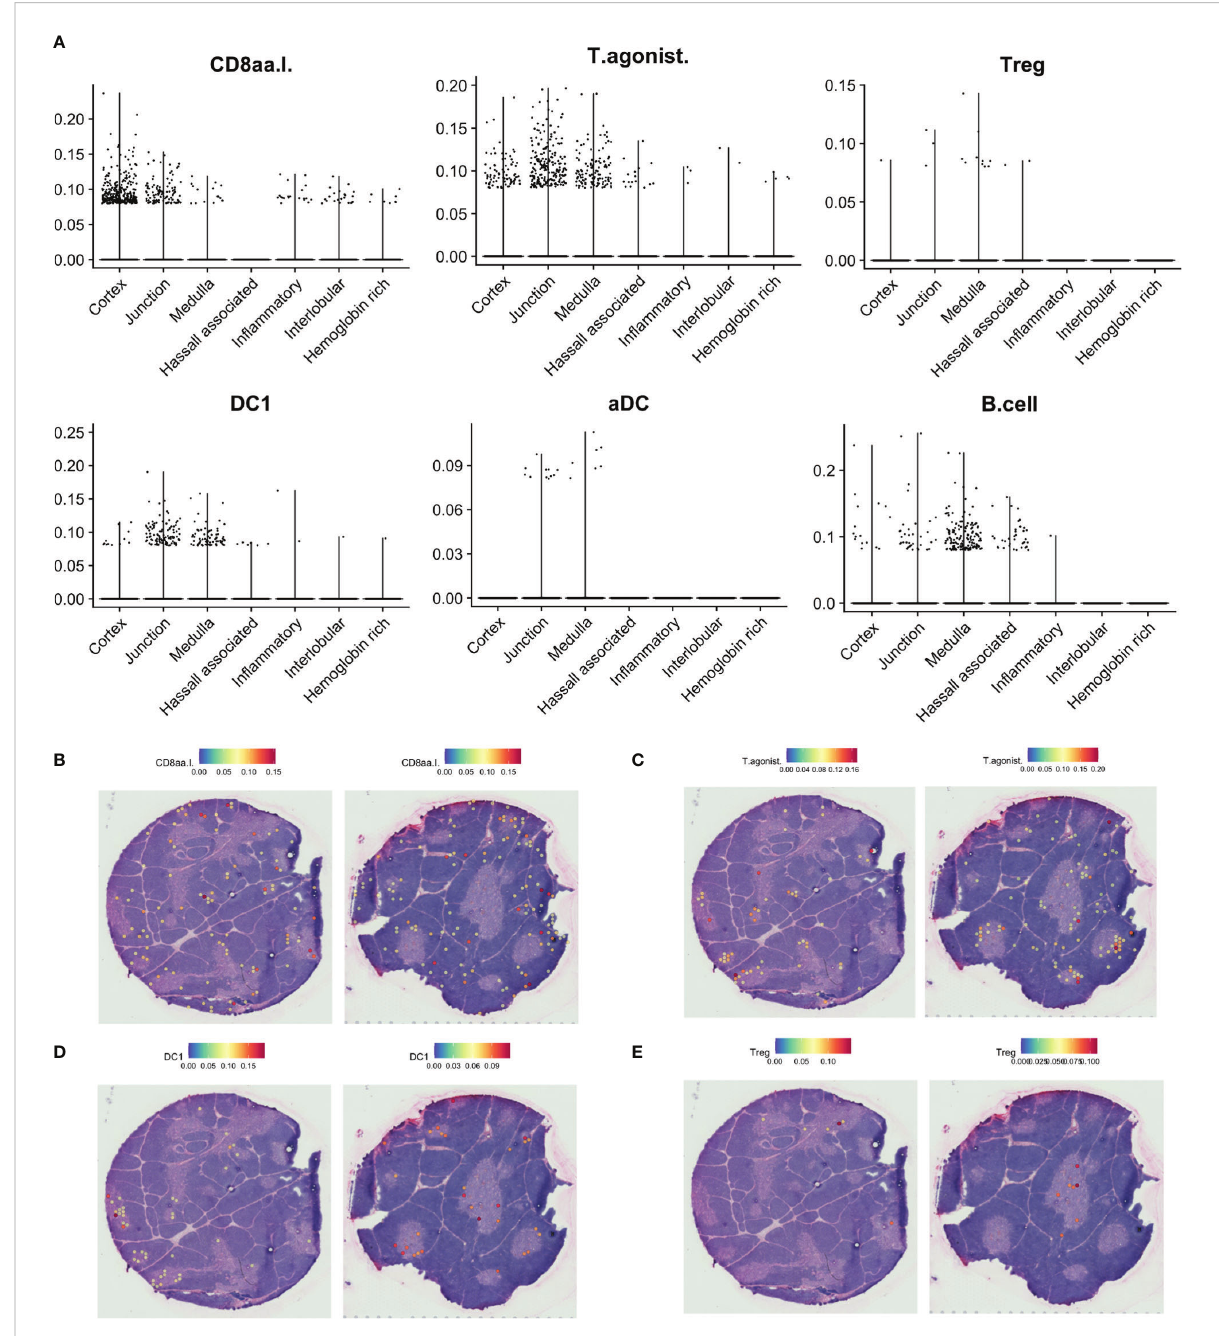
FIGURE 7 Predicted localisation of selected agonist selected and antigen-presenting cell populations by SPOTlight. (A) . Predicted proportion of selected populations among tissue spots. (B – E) . Localisation of spots predicted to include selected cell populations on representative tissue